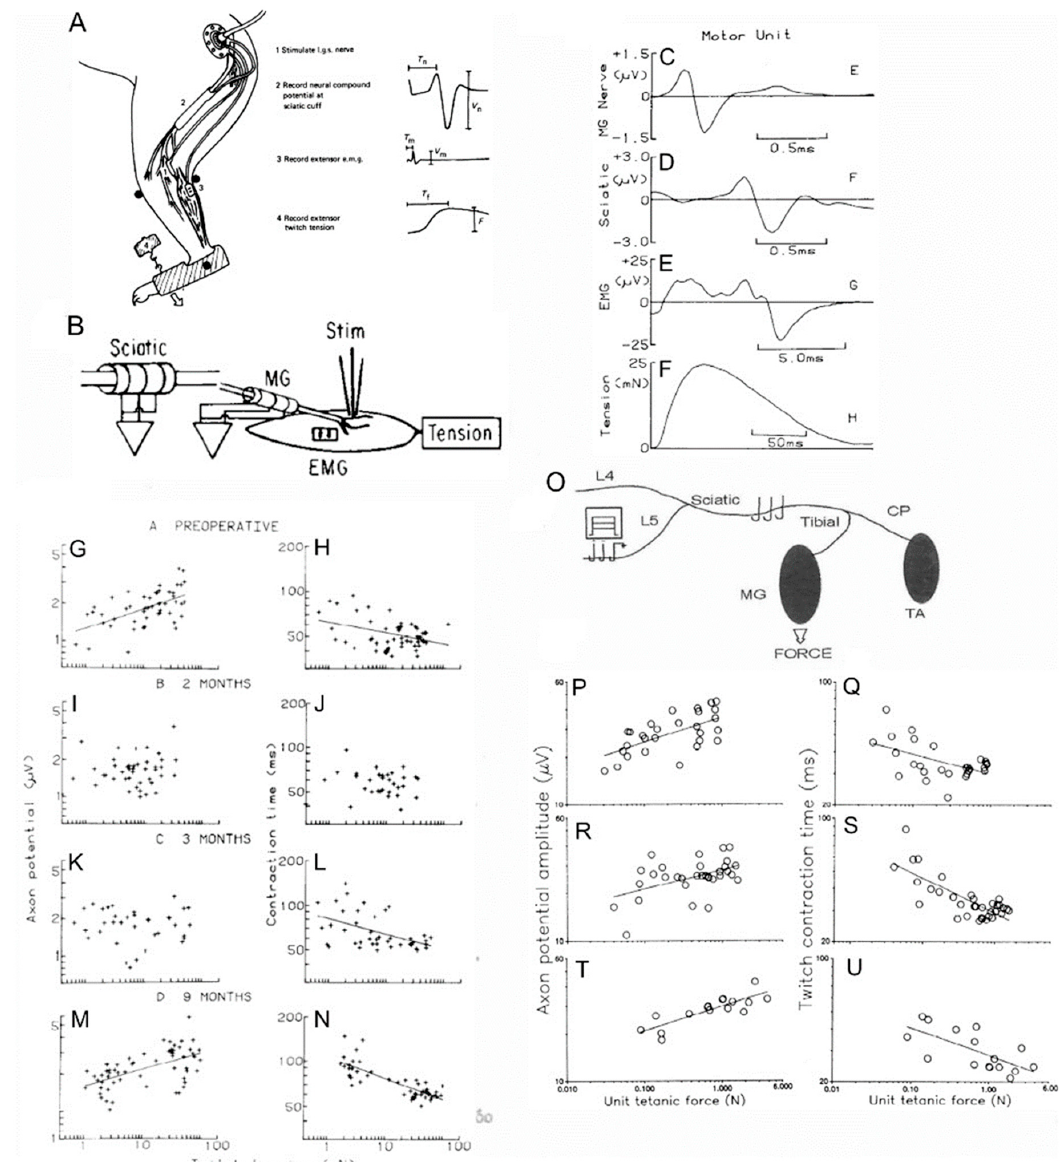
Figure 8. Size relationships in cat medial gastrocnemius (MG) muscles after complete and partial nerve injuries. At regular intervals of 10–14 days, the cat was anesthetized with fluorothane. The foot of the operated hindlimb was encased in a special boot that was attached to a force transducer to record isometric muscle and motor unit (MU) forces in response to stimulation of the MG nerve via nerve cuff electrodes ( A ) and in response to stimulation of single MG nerves via a needle electrode inserted through the skin into the endplate region of the MG muscle ( B ). The MU action potentials on the MG ( C ) and sciatic ( D ) nerves were recorded from implanted nerve cuff electrodes. The MU electromyographic action potential (EMG; E ) was recorded from EMG pad electrodes on the muscle surface and the twitch tension ( F ) was recorded with the force transducer attached to the boot. MU action potential amplitude was directly correlated with the twitch tension of the innervated muscle fibers ( G ) and inversely correlated with the contraction times of the twitch contractions ( H ). These correlations are in accordance with Henneman’s size principle (see text). The inverse relationship demonstrates that force increases as contraction times become shorter with the fast MUs being the most forceful and the slow MUs being the least. Early during reinnervation, the size relationships were lost when each nerve reinnervated muscles fibers of different histochemical types( I , J ) but they returned with time ( K – N ) as the heterogenous muscle fibers were respecified by their new